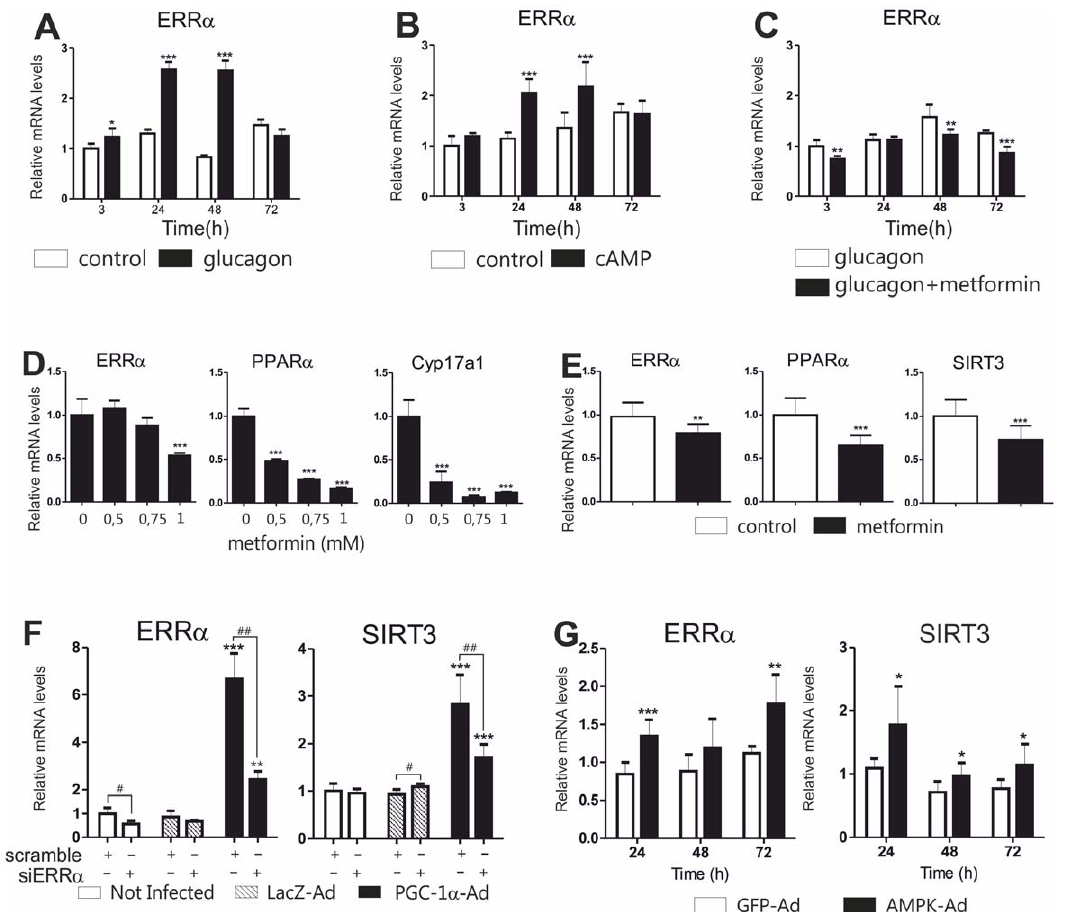
Figure 2. Involvement of ERR a in regulation of SIRT3 by metformin. Effect of A) glucagon (5 m g/ml), B) cAMP (50 m M 8-Br-cAMP) and C) glucagon (5 m g/ml) combined with metformin (1 mM) on ERR a expression in mouse primary hepatocytes. Cells were collected at indicated time points and expression of ERR a mRNA measured with qPCR. D) Mouse primary hepatocytes were treated with metformin as indicated, collected after 24 hours and mRNAs were measured with qPCR. In panels A-D, the data are presented as mean + SD (n=3). Statistical significance to control samples **P , 0.01, *** P , 0.001 (ANOVA, Bonferroni post hoc test). E) Effect of metformin treatment on ERR a and SIRT3 mRNA expression in the liver. Mice (n=7) were treated for seven days with metformin 300 mg/kg i.g. once daily for 7 days. Control animals received physiological saline only. Statistical significance to control samples **P , 0.01, *** P , 0.001 (Student two tailed t-test). F) Effect of ERR a siRNA on SIRT3 expression in mouse primary hepatocytes. Adenoviruses were used at MOI 0.1. Values represent mean + SD, n=3. Data represent fold change relative to the samples treated with scramble siRNA and not infected with any of the adenoviruses. A statistically significant effect of the adenovirus treatment is indicated with asterisks, ** P , 0.01, ***P , 0.001 (ANOVA, Bonferroni post hoc test). A statistically significant effect of the ERR a siRNA treatment compared to the scramble siRNA is indicated with hash marks, # P , 0.05, ## P , 0.01 (Student two tailed t-test). G) Effect of AMPK on SIRT3 and ERR a expression. Mouse primary hepatocytes were infected with AMPK-Ad or GFP-Ad (MOI=2) or left untreated. Cells were collected at indicated time points and mRNA expression measured with qPCR. Values represent mean + SD, n=4. Data represent fold change compared to untreated controls at a given time point. * P , 0.05, ** P , 0.01, ***P , 0.001, statistical significance compared to GFP-Ad (Student two tailed